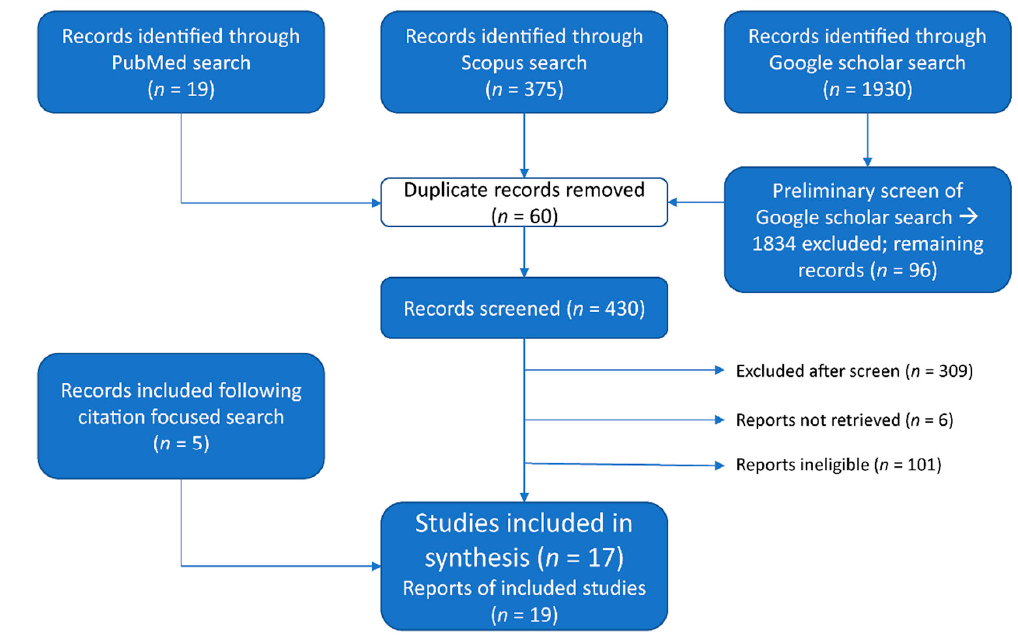
Figure 1. Search strategy as per the 2020 PRISMA guidelines.